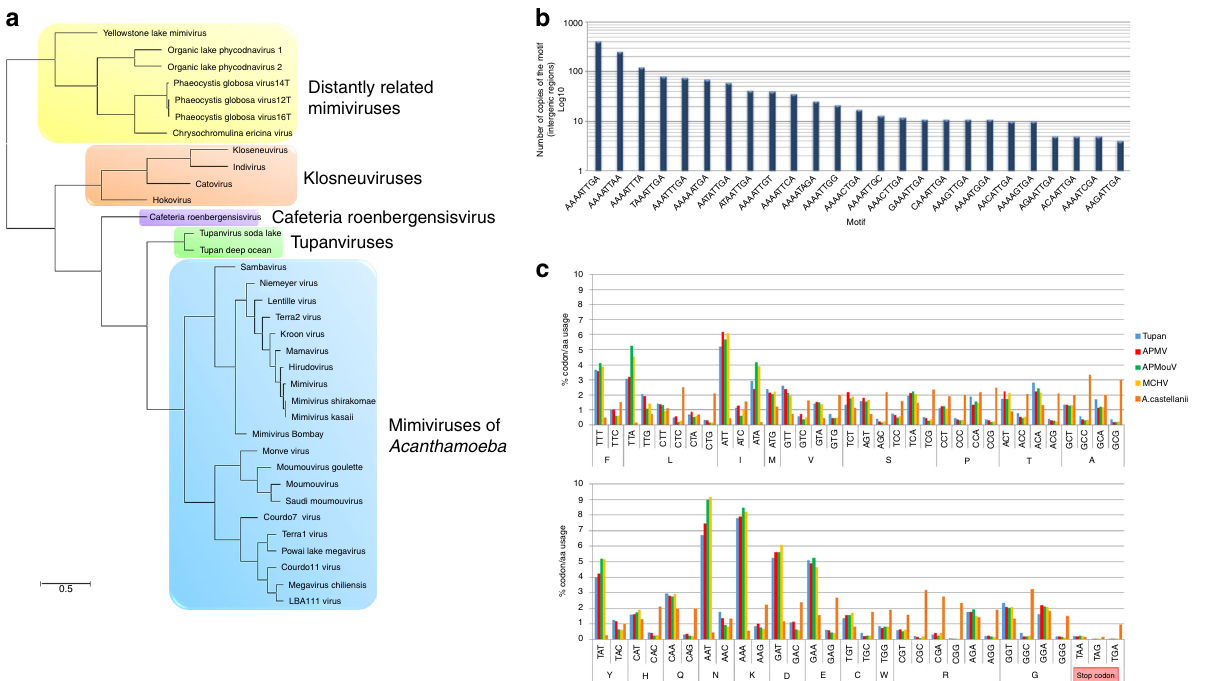
Fig. 4 Tupanvirus soda lake hierarchical clustering, promoter ’ s motifs and amino-acid usage analysis. a Hierarchical clustering tree based on presence- absence matrix of cluster of orthologous genes shared by Mimiviridae members. b Frequency of mimivirus AAAATTGA canonical promoter motifs in Tupanvirus intergenic regions. We also analyzed the presence of the AAAATTGA motif with SNPs, considering each motif position. c Comparative amino- acid usage analysis of Tupan, A . castellanii and mimivirus lineages a , b and c . The amino-acid usage for protein sequences was calculated using the